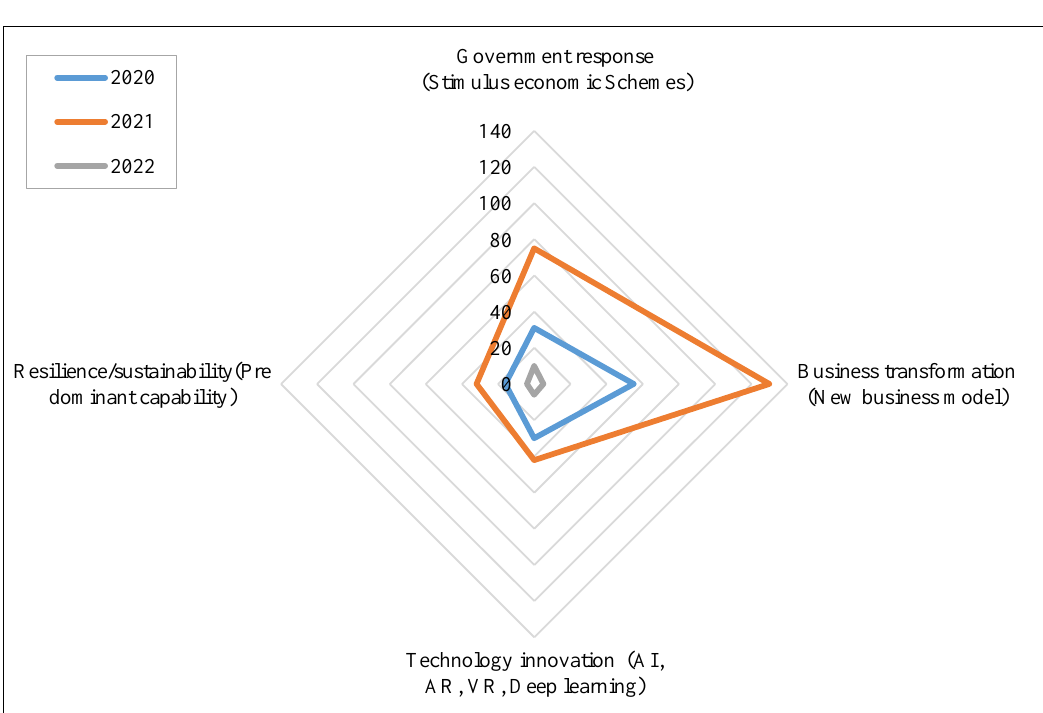
Figure 3. Publication trends and contents